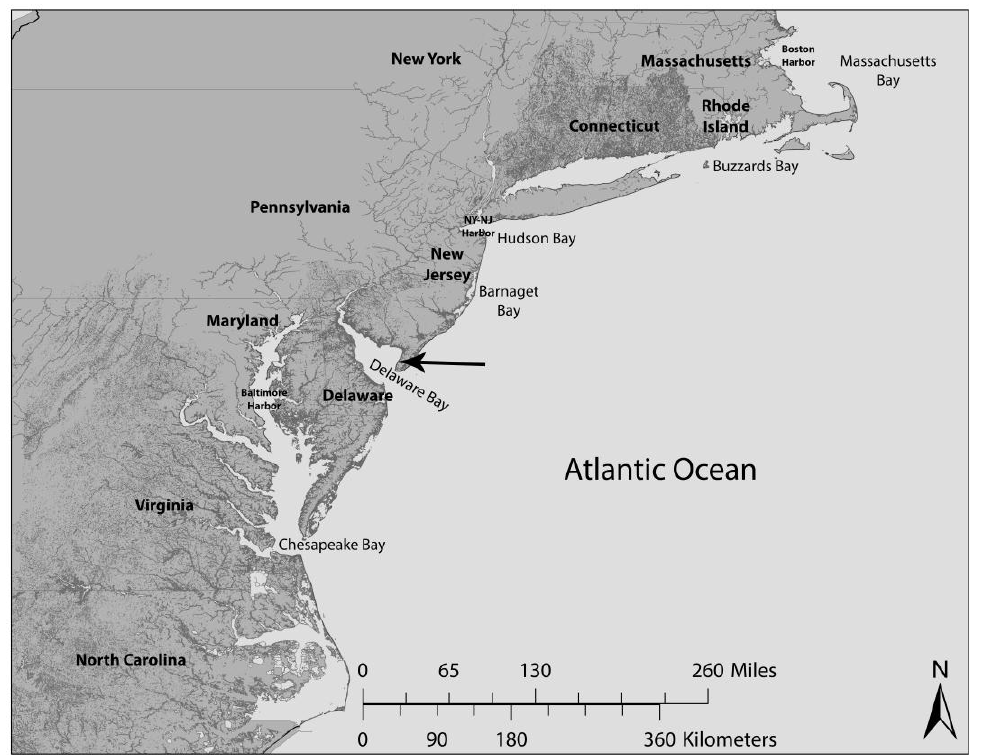
Figure 1. Map showing location of collection of blood of shorebirds and the eggs of horseshoe crabs (see arrow) along Delaware Bay.